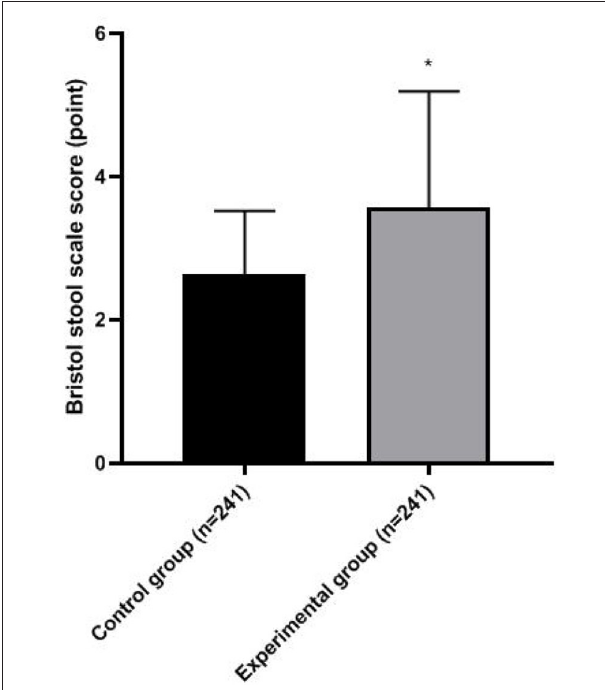
FIGURE 3 | Quality of life of two groups. Compared with the control group, * p <